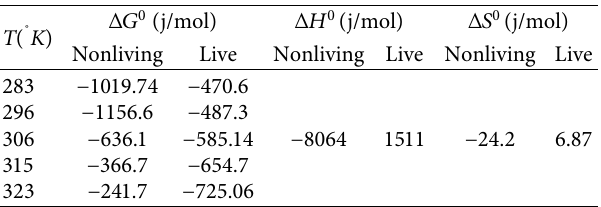
Table 2: Termodynamic parameters of Pb (II) uptake by Peni- cillium notatum in the nonliving state.